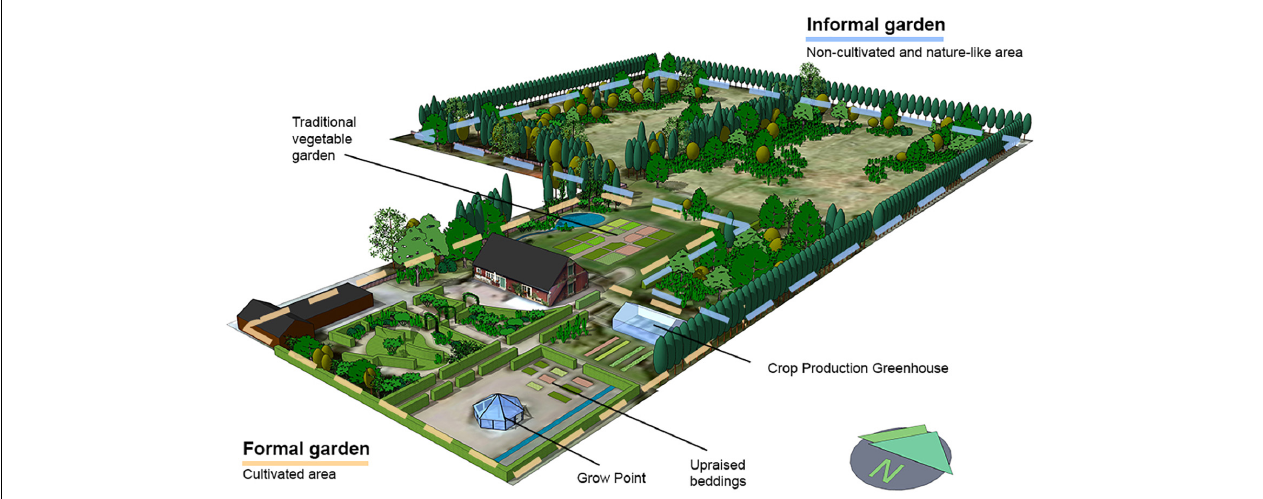
FIGURE 1 | Alnarp Rehabilitation Garden (2 ha) is divided into two main areas; the formal and cultivated garden (marked with yellow a dotted line) and the nature area (marked with a blue dotted line). Illustration by Cerwén G.